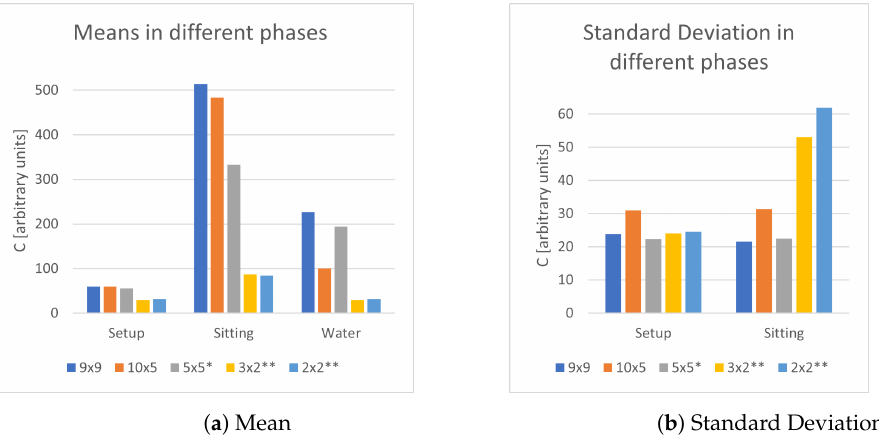
Figure 2. Study of different areas of sensing plates. * Auto-calibration occurred during water frames; ** Auto-calibration occurred both in water and sitting frames.